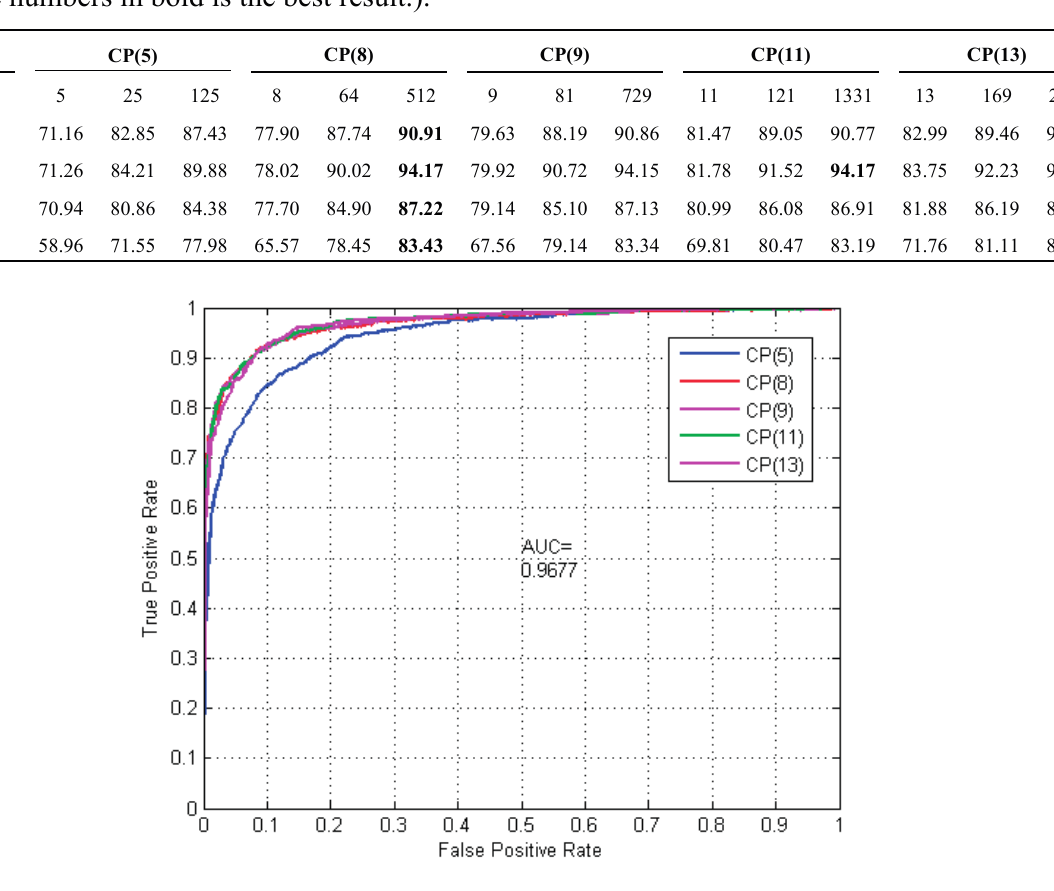
Figure 1. Receiver Operating Characteristic (ROC)